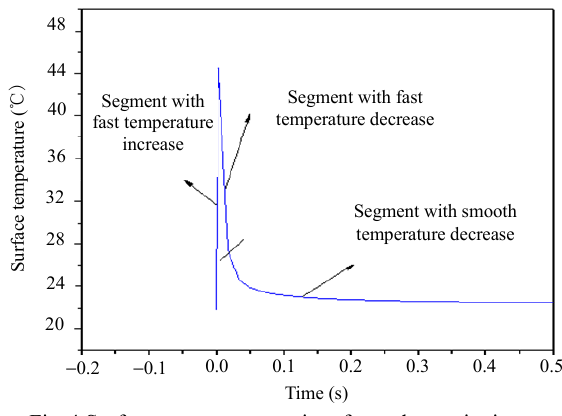
Fig. 4 Surface temperature varies after pulse excitation.